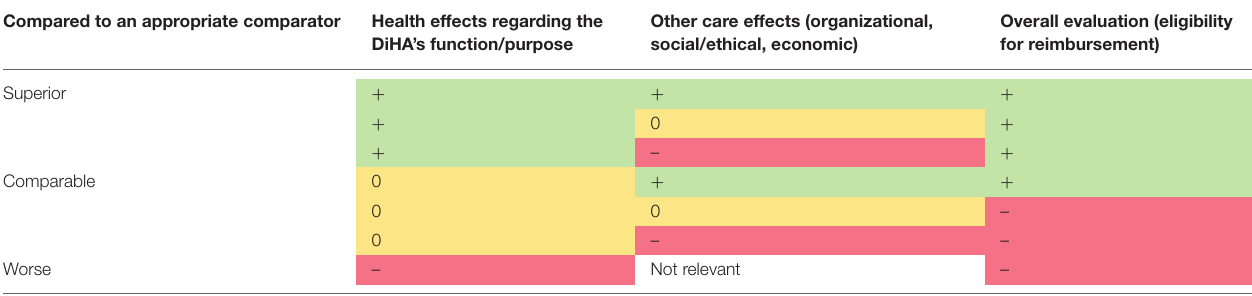
TABLE 4 | Relationship between health effects and other care effects. Compared to an appropriate comparator